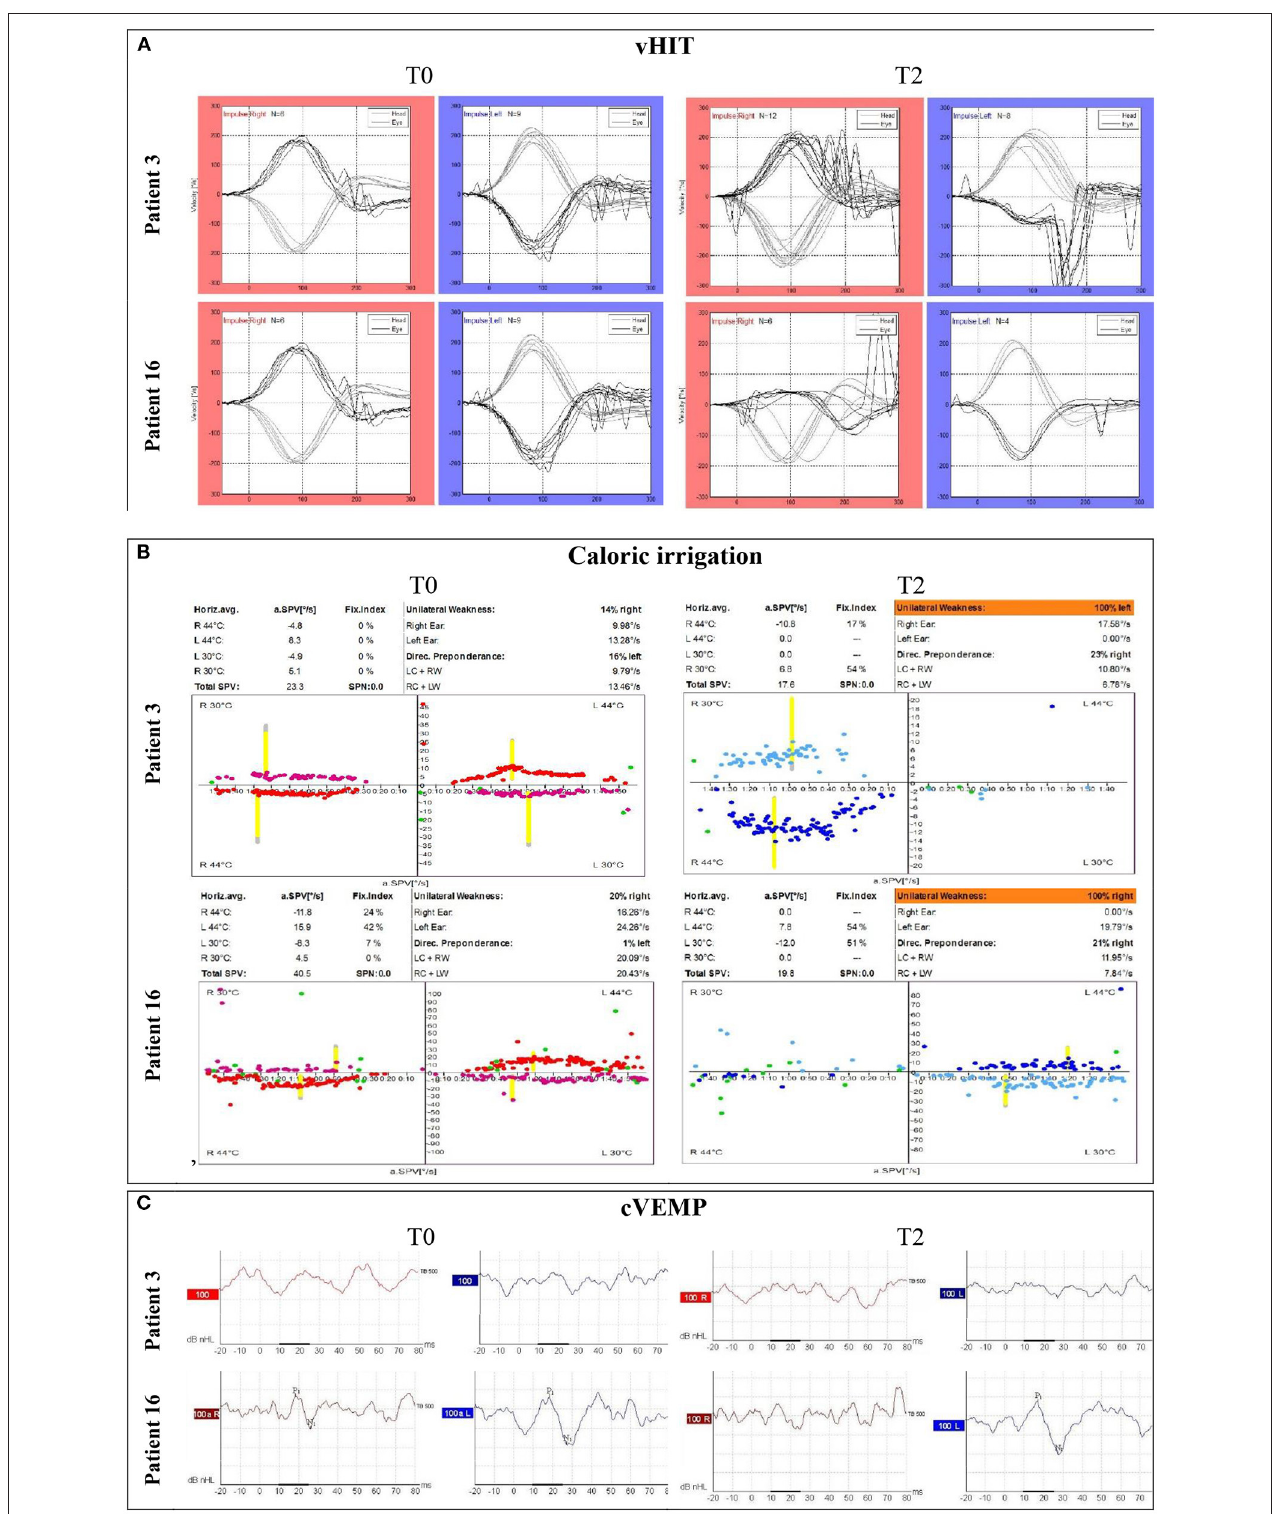
FIGURE 1 | Preoperative and postoperative raw data for patients 3 and 16 at T0 and T2, respectively. (A) vHIT tracings, (B) raw caloric irrigation test data including total SPV and UW, and (C) cVEMP tracings.